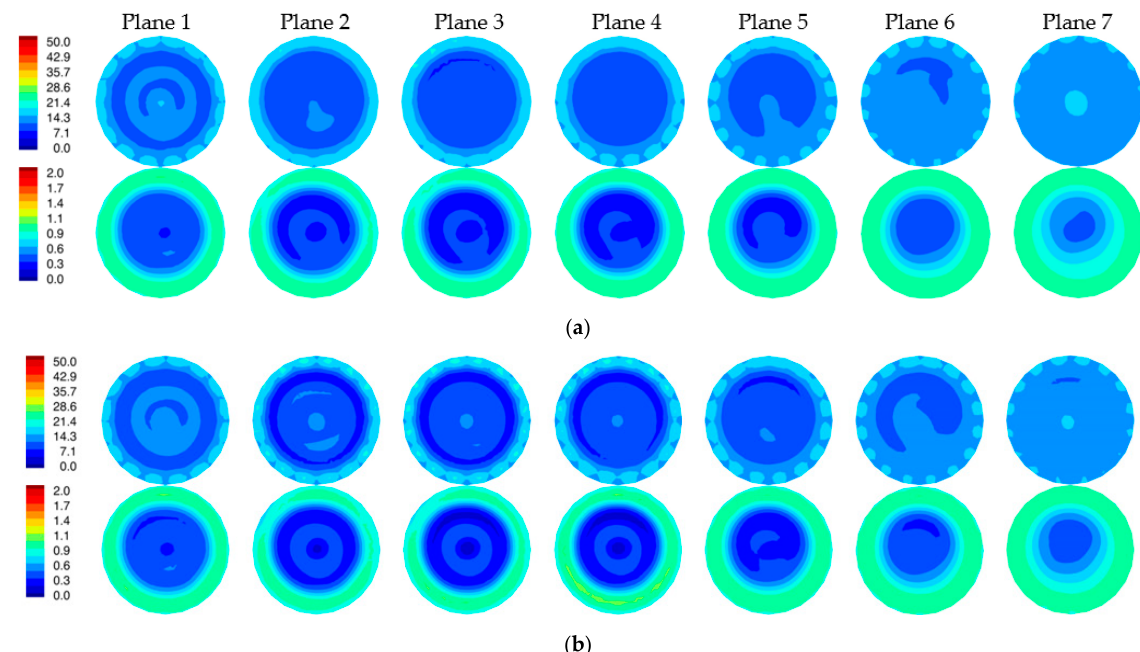
Figure 8. Reconstructed 2D 1300 MHz permittivity ( top ) and conductivity ( bottom ) images for all seven planes of the simulated breast phantom for the cases with ( a ) and without ( b ) the skin layer, respectively.